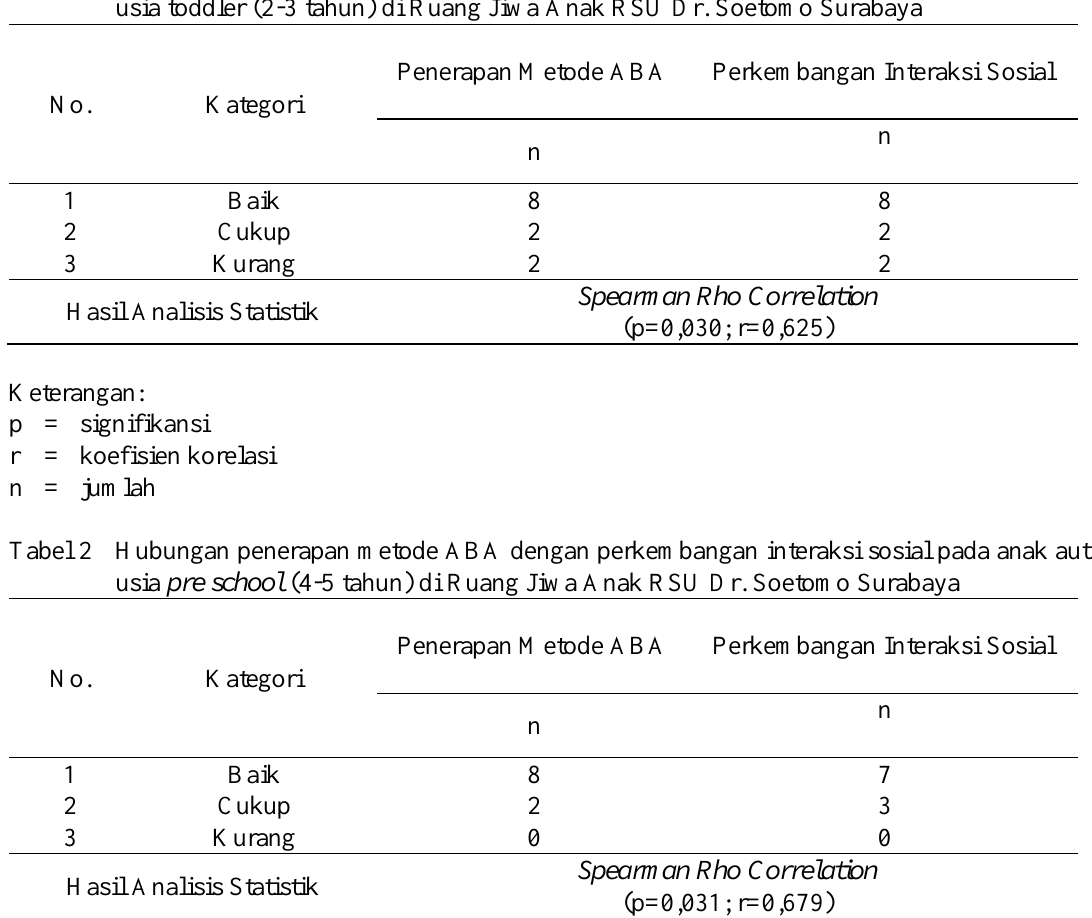
Tabel 1. Hubungan penerapan metode ABA dengan perkembangan interaksi sosial pada anak autis